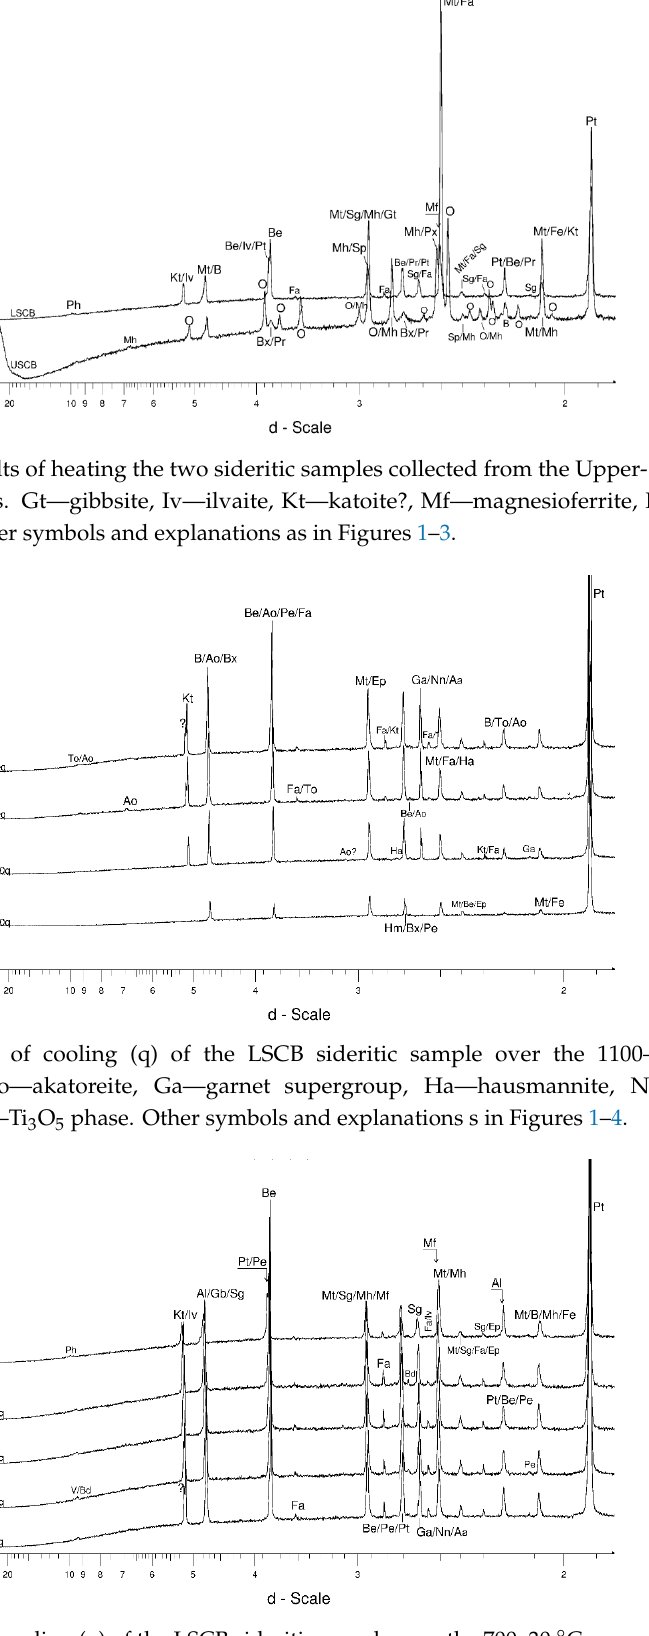
Figure 6. Results of cooling (q) of the LSCB sideritic sample over the 700–30 °C range. Bd—bredigite, Gb—gibbsite, V—vesuvianite. Other symbols and explanations as in Figures 1–5.